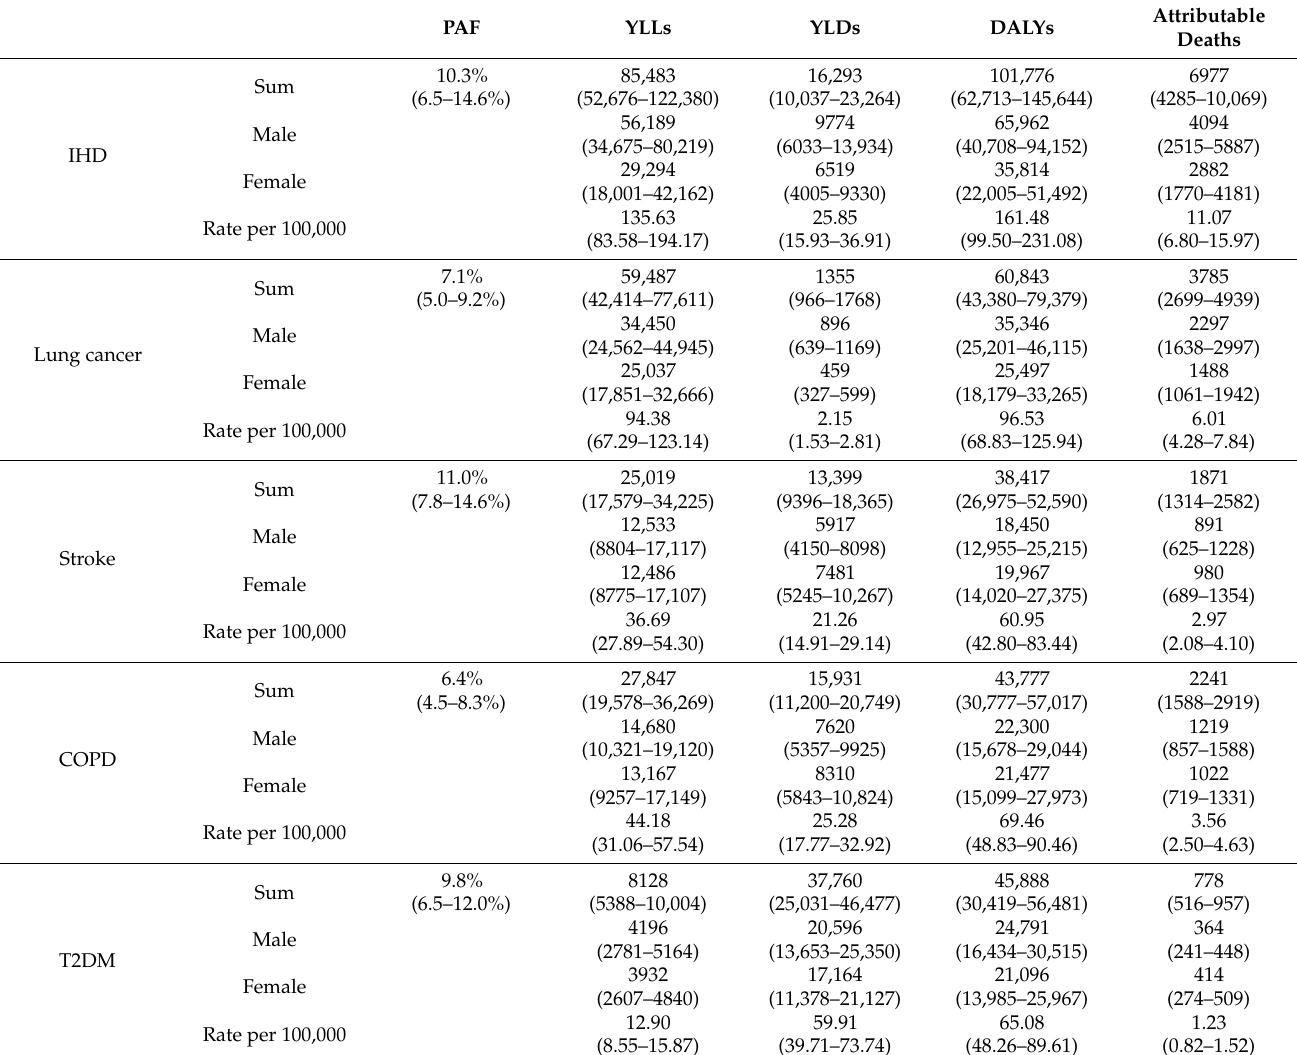
Table 3. PAF, YLLs, YLDs, DALYs, and attributable deaths per health outcome and sex attributable to long-term PM 2.5 exposure in 2018 (95% UI in